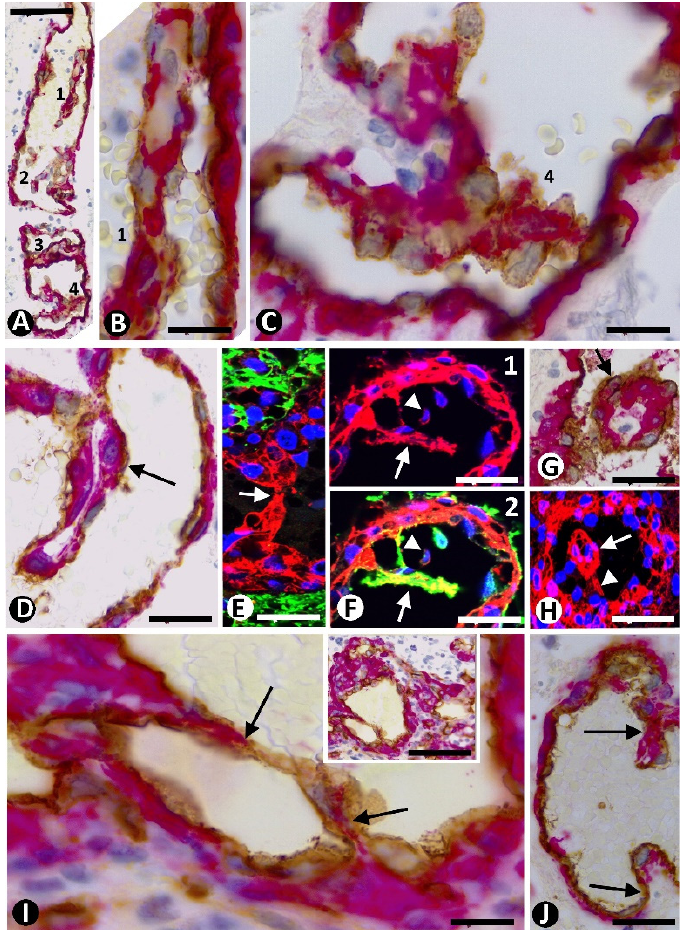
Figure 7. Pillars with an endothelial cover and a pericytic core in dilated vessels of GBM. ( A ) Pillars (1–4) are observed in a vessel. ( B , C ) Pillars 1 and 4 at higher magnification. ( D ) A pillar (arrow) presenting a core with α SMA + pericytes (red) and a cover formed by CD34 + ECs (brown). ( E – H ) Characteristics of the pillars in longitudinal and cross sections (arrows). Note in ( F ) and ( H ) that thicker pillars give rise to thinner pillars (arrowhead). ( I ) Detailed view of a pillar in which processes of pericytes are only perceptible in the ends of the pillars (arrows) (insert at lower magnification). ( J ) Pillars (arrows) originating from two opposite points of the vessel wall. ( A – D , G , I , J ) Double immunochemistry for CD34 (brown) and α SMA (red). Hematoxylin counterstain. ( E ) Double immunofluorescence for GFAP (green) and α SMA (red). DAPI counterstain. ( F1 , H ): Immunofluorescence for α SMA (red). DAPI counterstain. ( F2 ) Double immunofluorescence for CD34 (green) and α SMA (red). DAPI counterstain. Bar: ( A , E ) 45 µ m, ( B , C , I ) 15 µ m, ( D ) 30 µ m, ( E ) 45 µ m, and ( F – H , insert of I , J ) 40 µ